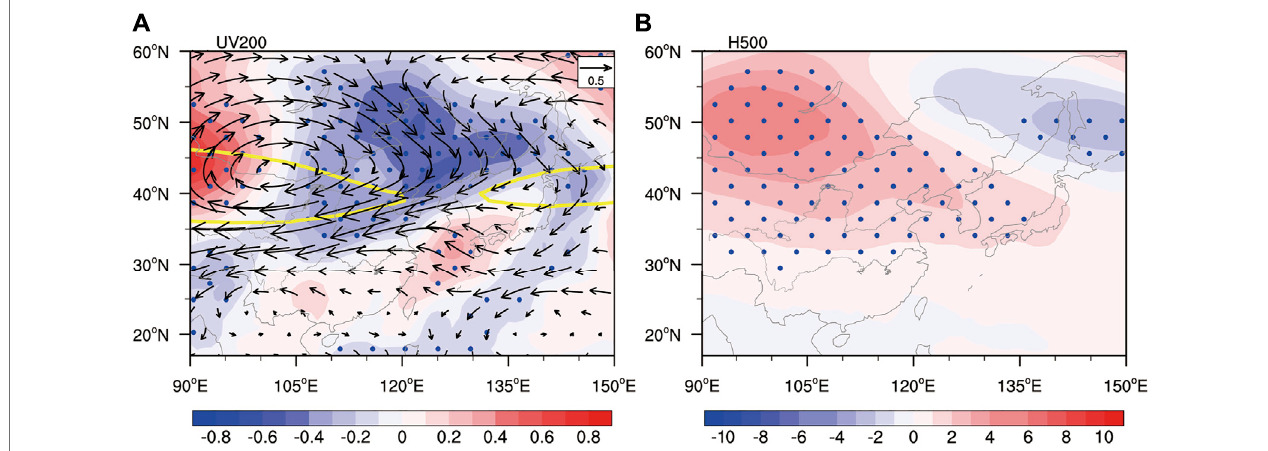
FIGURE 9 | Regression maps of the 9-years low-pass fi ltered circulations in summer (JJA) concerning the SSDI. (A) 200-hPa wind (vector; m s − 1 ) and V wind (shading; m s − 1 ), (B) 500-hPa geopotentialheight(gpm). Thestippling denotes theregression coef fi cients statistically signi fi cantat the95%con fi dencelevel. Theyellow solid lines in (A) indicate the climatological U wind of 25 m s − 1 .